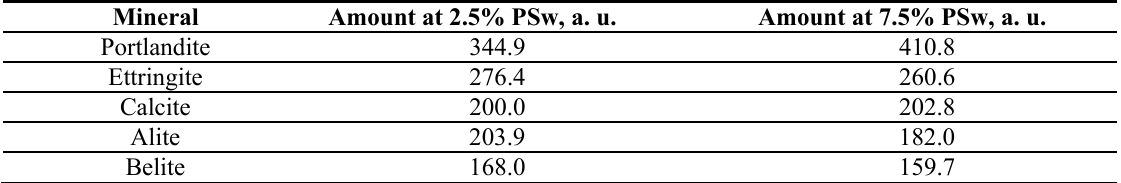
Table 2. Relative amounts of base minerals based on their